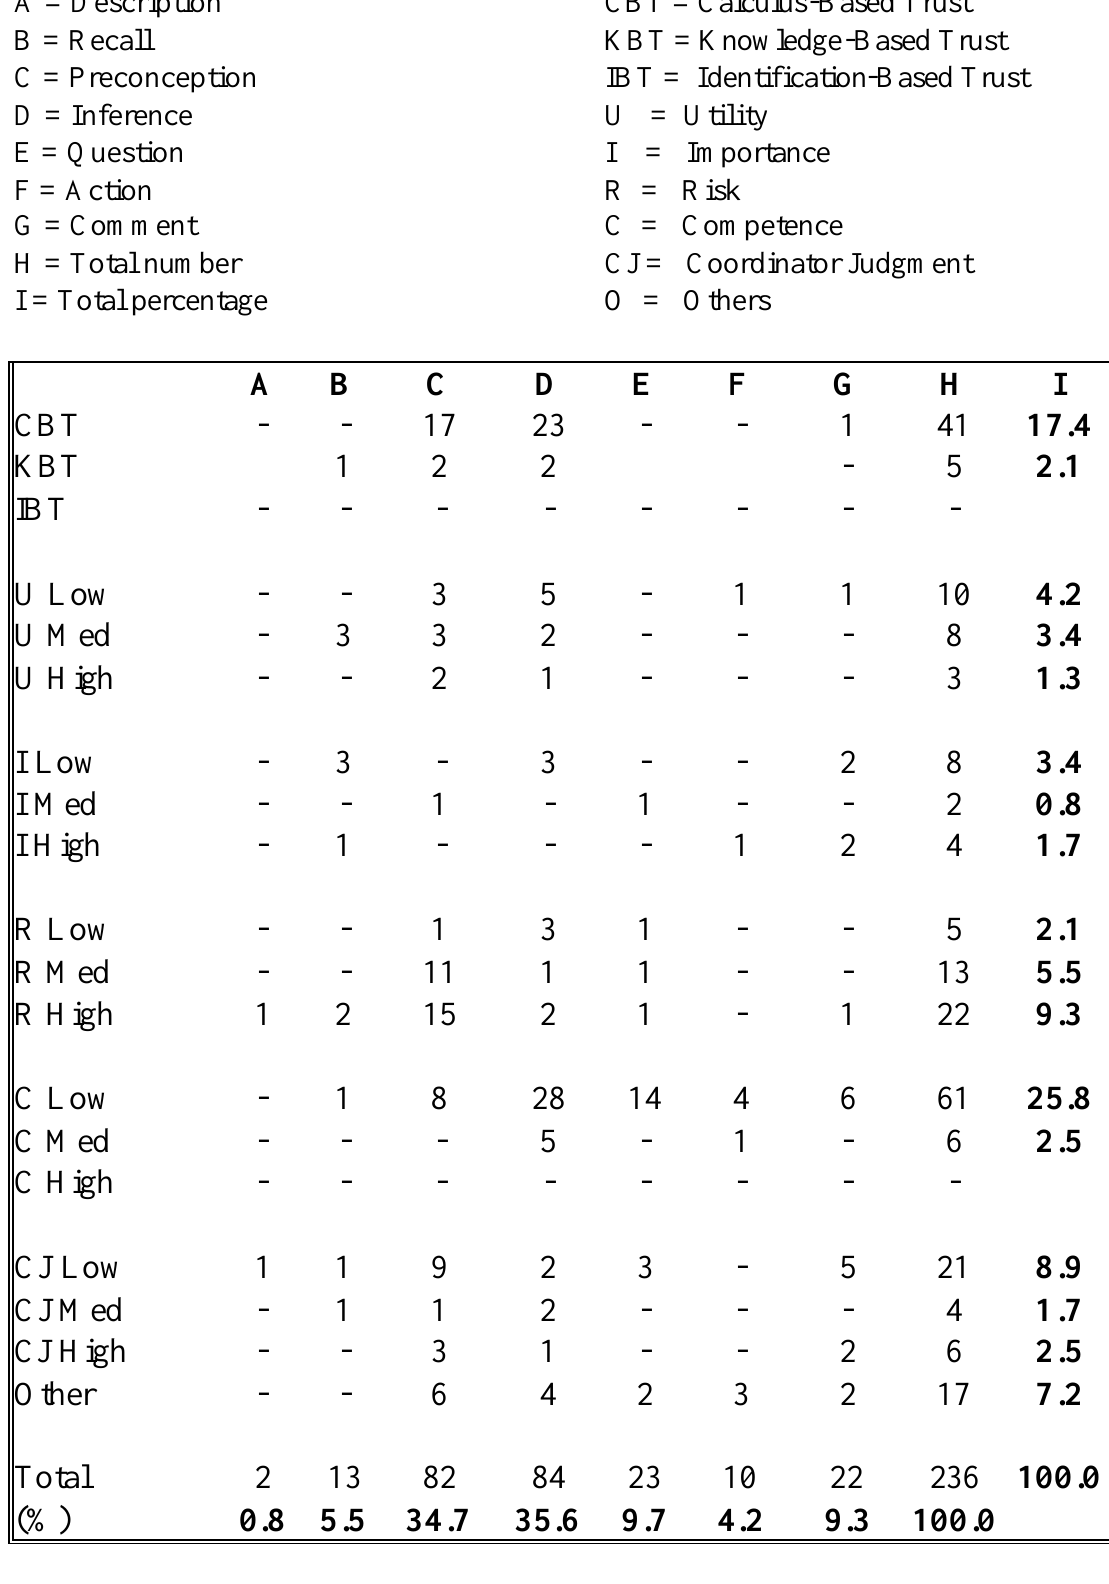
Verbal protocol frequency analysis for 30 Nigerian